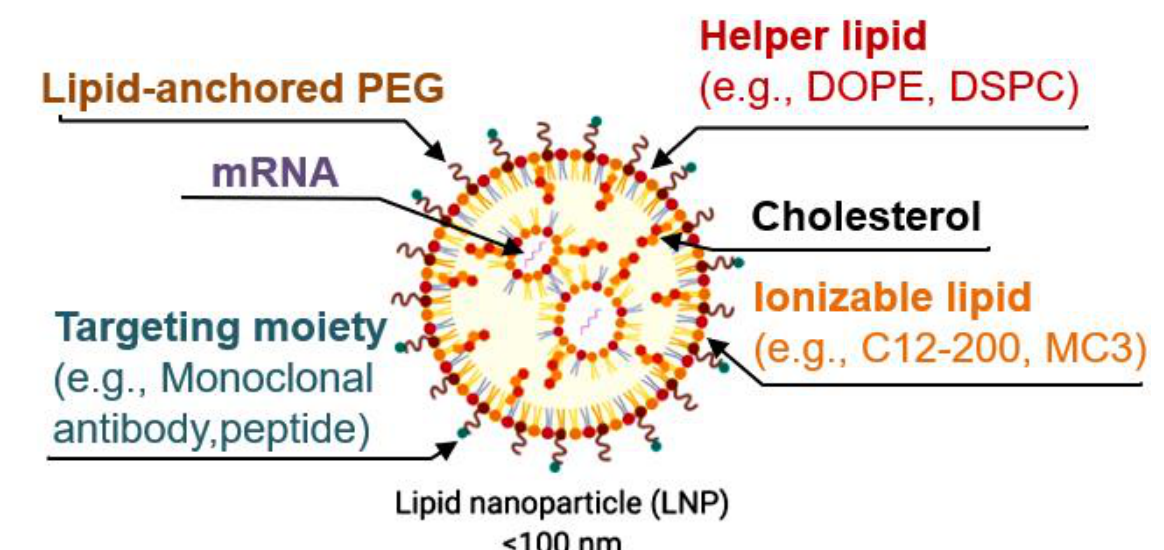
Figure 1. LNP formulation of mRNA. Components are mixed via chaotic mixing with a microfluidic device. The interaction of lipid nanoparticle with the lipid bilayer of eukaryotic cells then occurs. Fusion merges the lipids of the nanoparticle with the ones in the cell membrane, ultimately releasing the contents of the nanoparticles inside the cell. Adsorption occurs when the nanoparticles are attracted to the cell membrane by electrostatic forces, ultimately promoting the release of the cargo inside. Lipid exchange happens when the lipids from the cell membrane and the ones from the nanoparticle switch. Endocytosis then occurs when the phagocyte cells engulf the nanoparticles. The inclusion of a targeting moiety—a target cell-specific biomimetic ligand meant to bind an appropriate acceptor on a cell type—is often referred to as nanoparticle surface “functionalization” or “decoration”, and it is meant to improve targeted delivery of the RNA